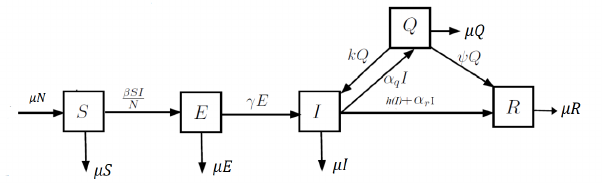
Figure 1. A compartmental model for the transmission dynamics of CBPP with antibiotic treatment, where, h ( I ) = aI is a saturated treatment b + I